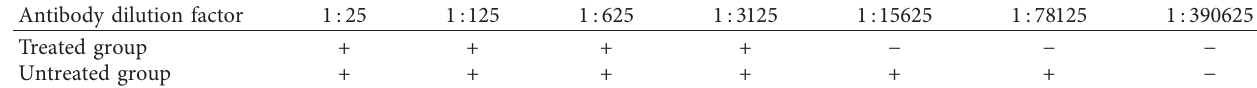
Table 1: Determination results of antibody solution at different dilutions.